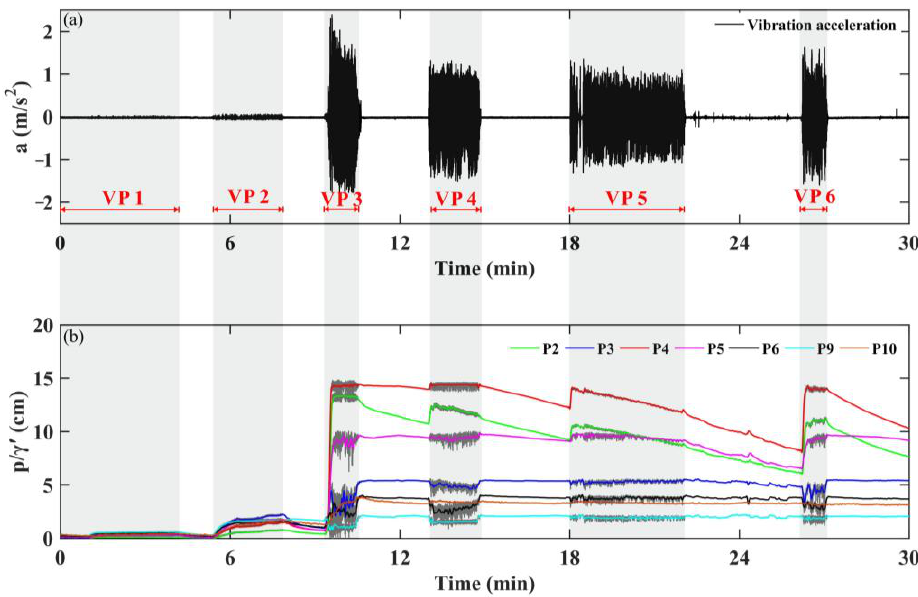
Figure 6. Time series of vibration acceleration ( a ) and excess pore pressure ( b ) in Test